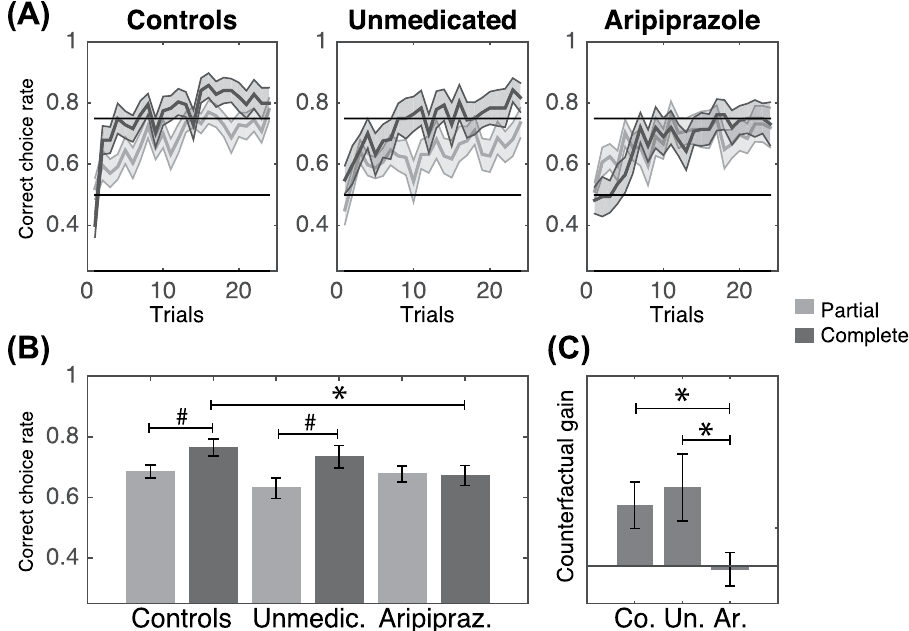
Figure 2. ( A ) Learning curves as a function of feedback information and group. The bold lines represent trial-by-trial average accuracy over the three sessions. The shaded areas between the thin lines represent the standard error of the mean with subject as the random factor. Light and dark grey represent partial and complete feedback conditions, respectively. ( B ) Average performance averaged across the 24 trials. ( C ) Average « counterfactual gain » (complete minus partial accuracy) (Co. = controls; Un. = unmedicated; Ar. = aripiprazole). # p < 0.05, one-sample t-test; * p < 0.05, two-sample t-test. The error bars represent the standard error of the mean with subject as the random